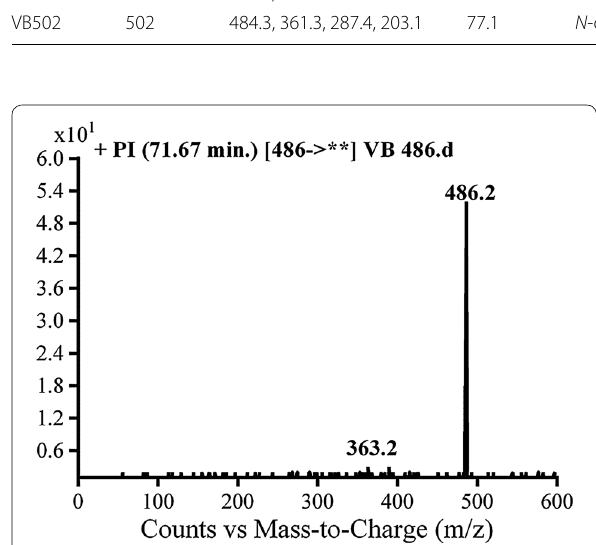
Fig. 5 PIs mass spectrum of